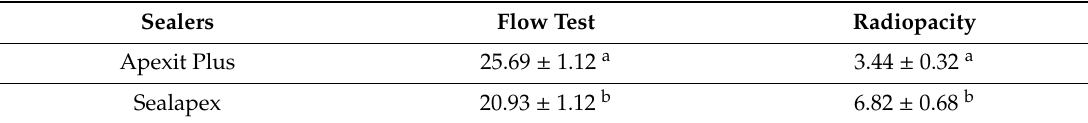
Table 1. Means and standard deviations of the flow test (mm) and radiopacity (mm Al) of the Apexit Plus and Sealapex